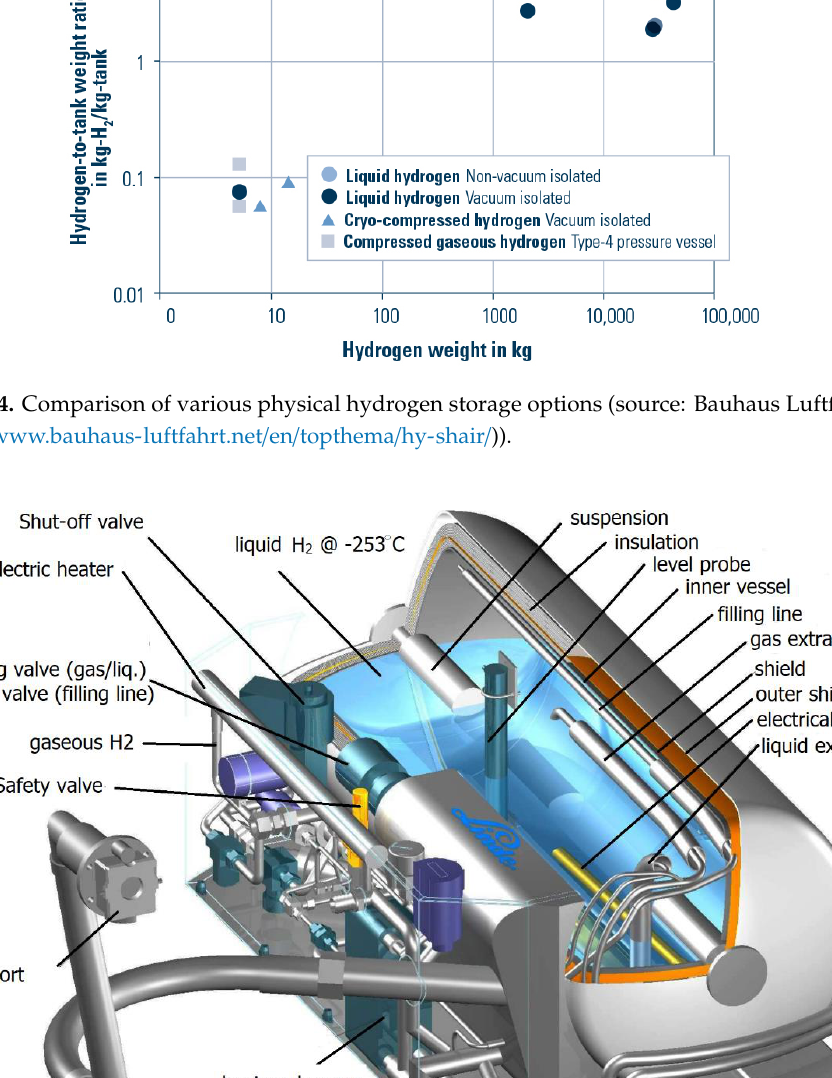
Figure 13. An overview of different hydrogen storage options